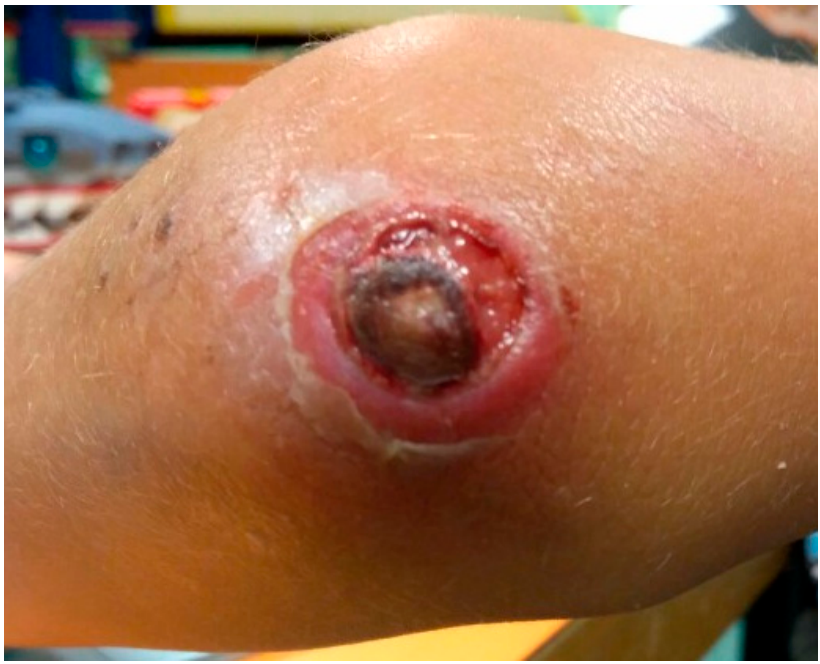
Figure 1. Elbow skin lesion of patient 1. Patient’s parents signed the written inform consent for publication.